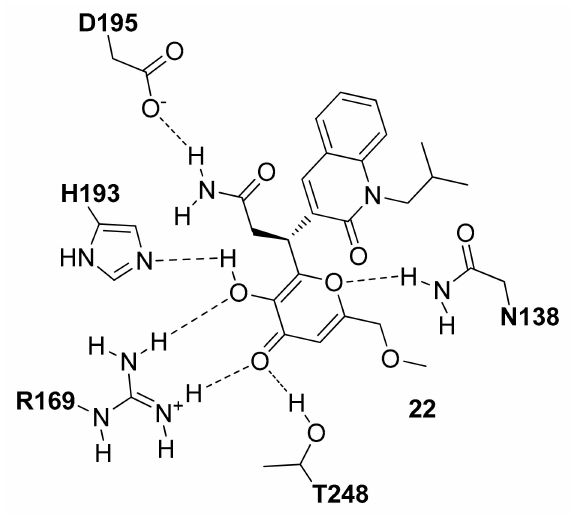
Figure 10. Schematic 2D representation of the 22 - h LDH5 H-bond interactions.